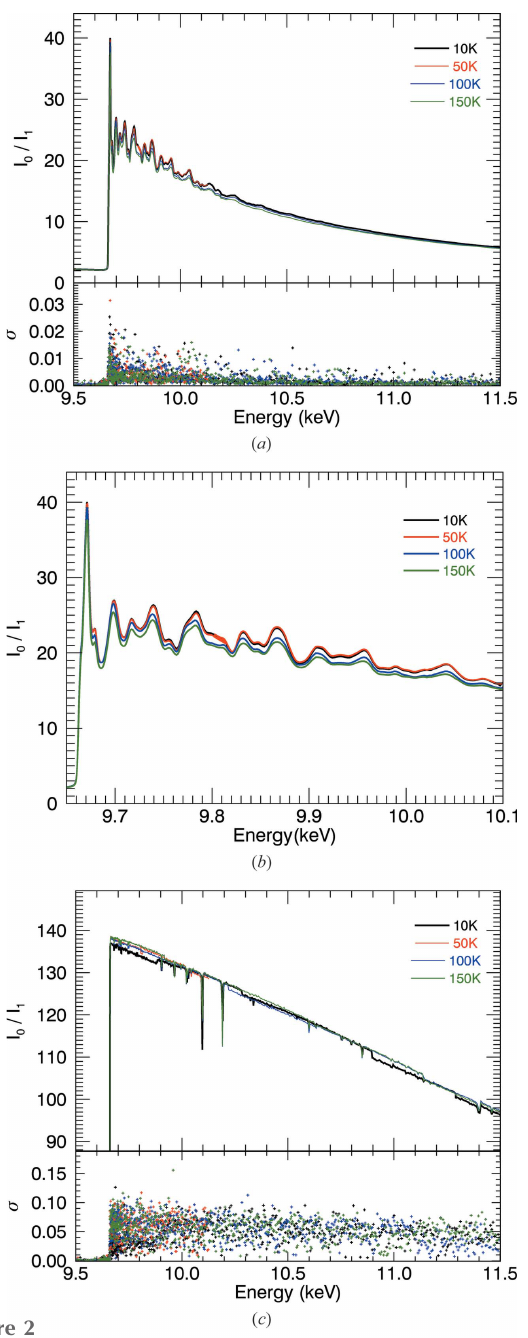
Figure 2 Transmission ratio of the downstream ( I 1 ) ion chamber normalized by the upstream ( I 0 ) ion chamber for ( a , b ) the 10 m m foil and ( c ) the 50 m m foil. The 10 m m data show highly detailed XAFS well beyond the edge, and temperature variation. The (cid:4) reported in ( a ) and ( c ) is the standard error of three repeated measurements, <0.1% for the 10 m m foil. All XAFS is lost in the 50 m m data, where I 1 / I 0 ’ exp( (cid:6)